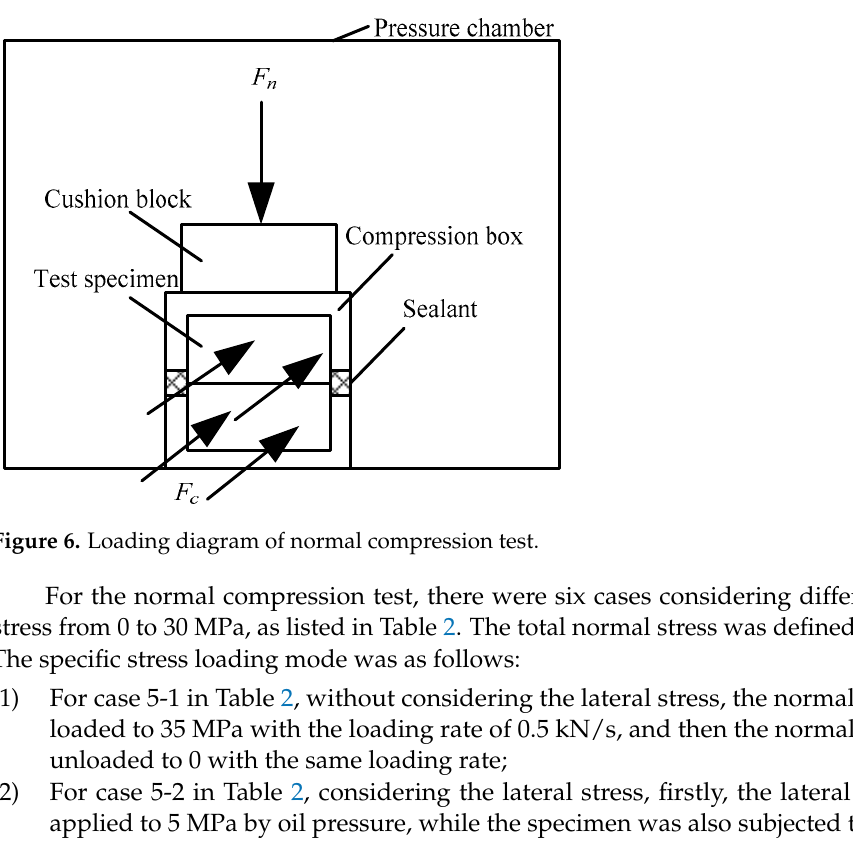
Table 2. The normal compression test loading